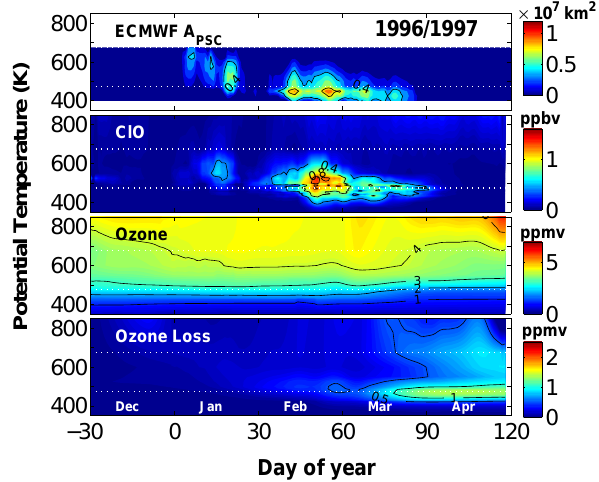
Fig. 3. Temporal evolution of the vertical distribution of potential PSC areas (top) and Mimosa-Chim simulations of ClO (second plot from the top), O 3 (third plot from the top), and ozone loss (bottom) inside the vortex for the Arctic winter 1996/1997. The ClO profiles are selected at 12UT and solar zenith angles below 89 ◦ . The white dotted lines represent 475K and 675K. The blue/red colors show relatively low/high values of PSC areas or mixing ratios of ClO, O 3 , and ozone